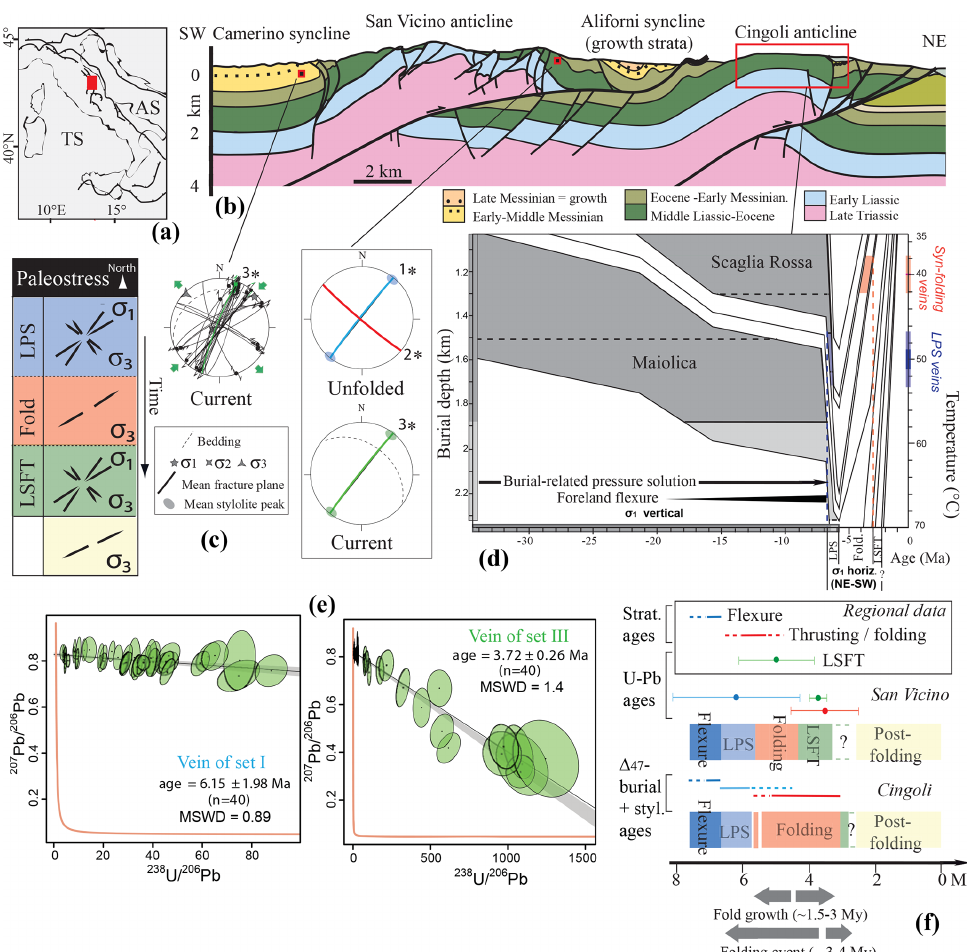
Figure 3. San Vicino and Cingoli anticlines. (a) Location (AS: Adriatic Sea; TS: Tyrrhenian Sea). (b) Cross section (modified after Mazzoli et al., 2002). (c) Orientation of the main sets of mesostructures (relative chronology, 1 to 3), reported in current or unfolded attitude on a lower-hemisphere Schmidt stereonet, and associated paleostress evolution; ∗ denotes mesostructures dated using U–Pb. (d) Burial model of Cingoli constructed considering thickness from stratigraphic and well data corrected for chemical and physical compaction (modified after Labeur et al., 2021). The range of depths reconstructed from sedimentary stylolite roughness inversion (with uncertainty shaded in light grey) is reported for each formation as grey levels. The results of clumped isotope analysis (i.e. temperatures of precipitation of vein cements at thermal equilibrium with the host rock) are reported for LPS-related veins (blue) and syn-folding veins (red). The deduced timing of the deformation stages is reported. (e) Age dating results for veins from the San Vicino anticline: Tera–Wasserburg concordia plots for carbonate samples showing 238 U/ 206 Pb vs. 207 Pb/ 206 Pb for veins of sets I (LPS-related) and III (LSFT-related) ( n – no. of spots). MSWD – mean square of weighted deviates. (f) Timing and duration of deformation stages. Regional data are from Mazzoli et al. (2002) (flexure), Calamita et al. (1994) (folding and thrusting), and Beaudoin et al. (2020b) (LSFT). Colour code for (c, f) : dark blue – flexure-related extension;